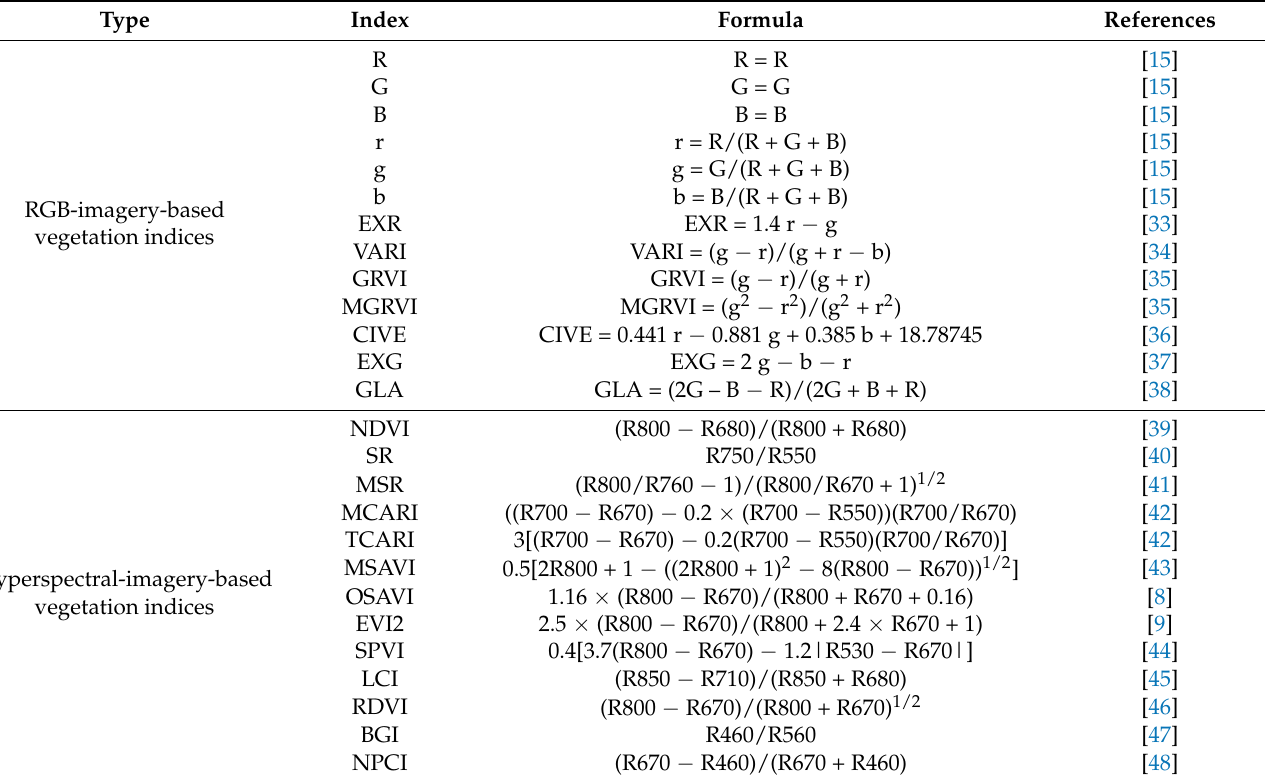
Note: R: red reflectance; G: green reflectance; B: blue reflectance; r: normalized red reflectance; g: normalized green reflectance; b: normalized blue reflectance; EXR: excess-red index; VARI: vegetation atmospherically resistant index; GRVI: green-red vegetation index; MGRVI: modified green-red vegetation index; CIVE: color index of vegetation; EXG: excess-green index; GLA: green leaf algorithm index; NDVI: normalized difference vegetation index; SR: simple ratio vegetation index; MSR: modified simple ratio index; MCARI: modified chlorophyll absorption ratio index; TCARI: transformed chlorophyll absorption ratio index; MSAVI: modified soil-adjusted vegetation index; OSAVI: optimized soil-adjusted vegetation index; EVI2: two-band enhanced VI; SPVI: spectral polygon vegetation index; LCI: linear combination index; RDVI: renormalized difference vegetation index; BGI: bare ground index; NPCI: normalized pigment chlorophyll ratio